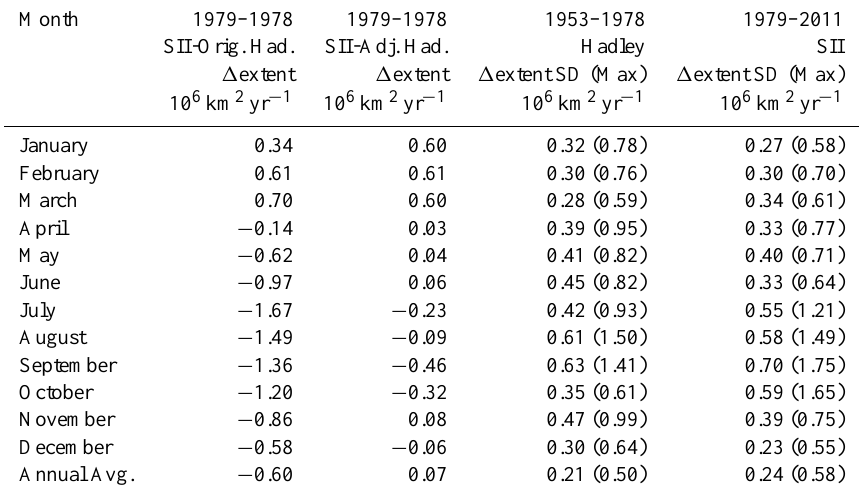
Table 3. Change in monthly extent between two consecutive years. The left two columns provide the change across the 1978 to 1979 Hadley to SII transition. The right two columns provide the standard deviation (SD) of the change (and maximum absolute change) for years within the Hadley period (1953–1978) and the SII period